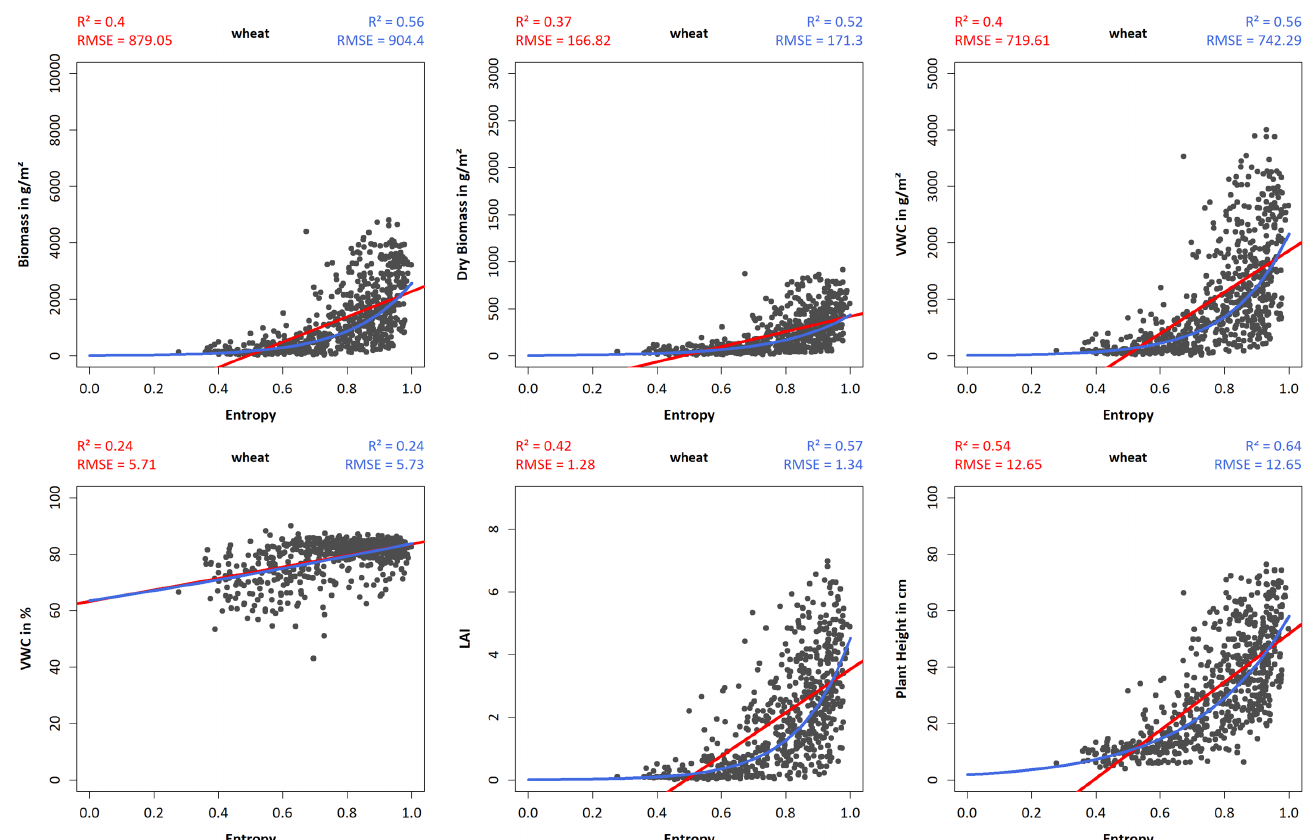
Figure 10. Scatter plots of entropy and biophysical parameters of wheat for BBCH stages 21–49: the regression lines, R 2 , and root mean square error (RMSE) are shown in red (linear regression) and blue (exponential